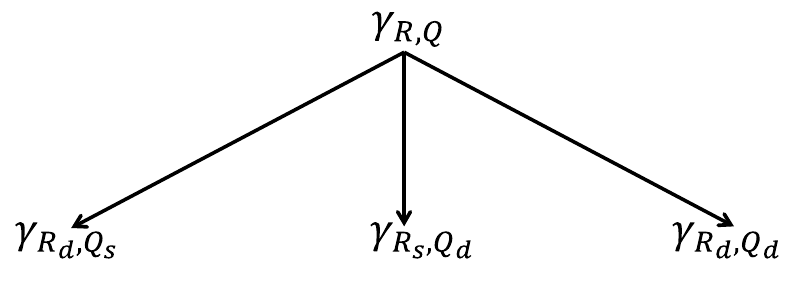
Figure 13. The Macklay kinematic.